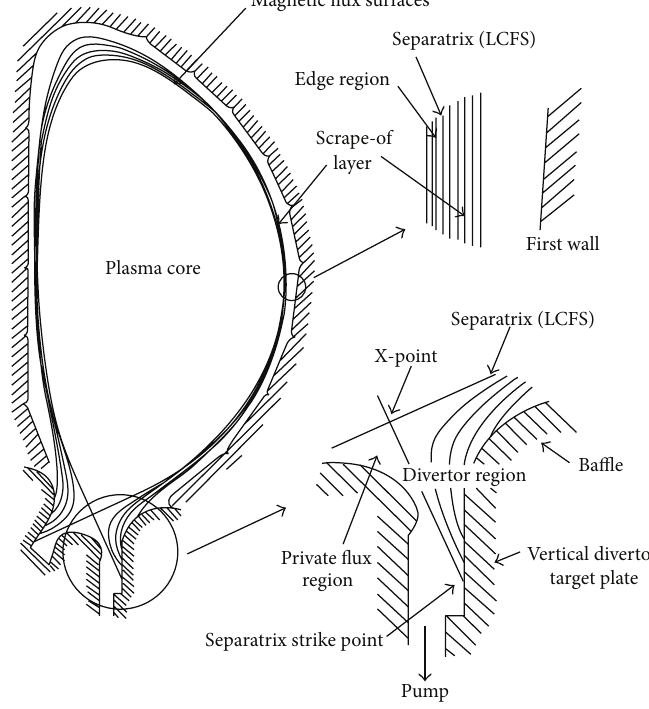
Figure 1: A schematic representation of the regions of the plasma and the boundary walls